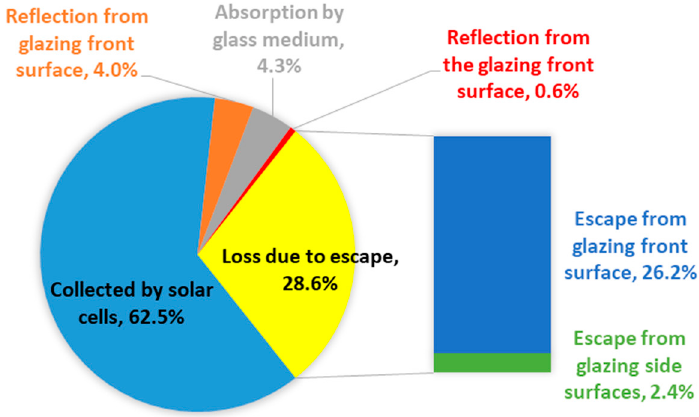
Figure 3. Light distribution within the CPV module with Lambertian rear reflectors.